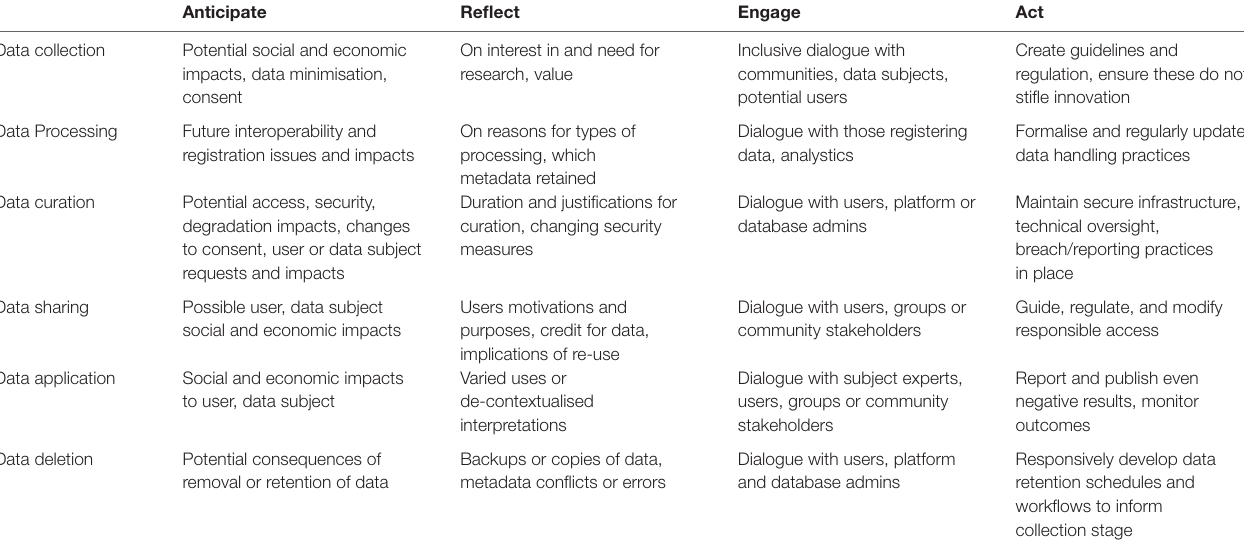
TABLE 1 | Examples of “responsible data governance” actions and relationships over the data lifecycle, arranged within the AREA RRI